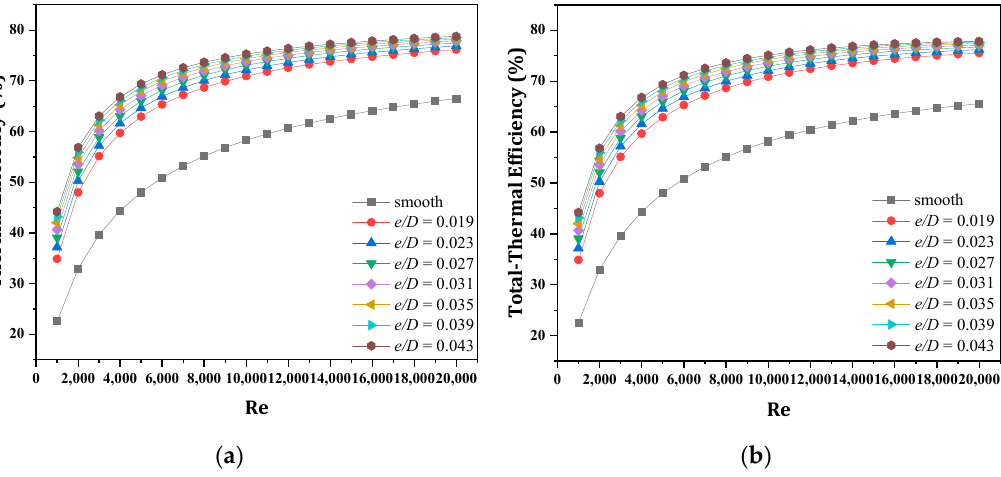
Figure 7. Useful energy (W) versus Re for smooth and roughened surfaces at various relative roughness heights e / D (in the range of 0.043–0.019).